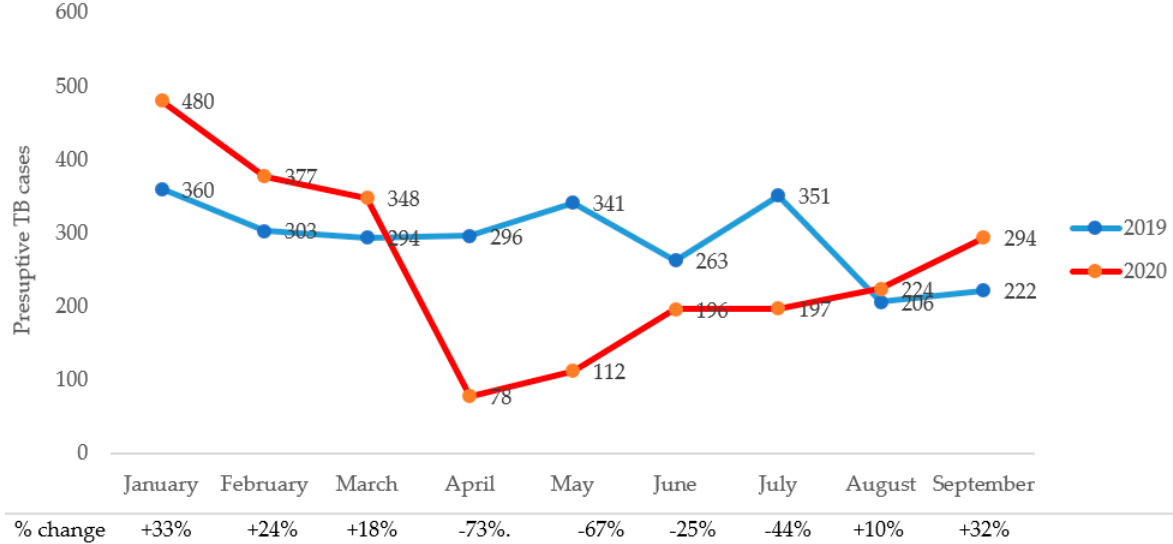
Figure 1. Comparison of presumptive TB cases during the pre- and intra-COVID-19 periods.